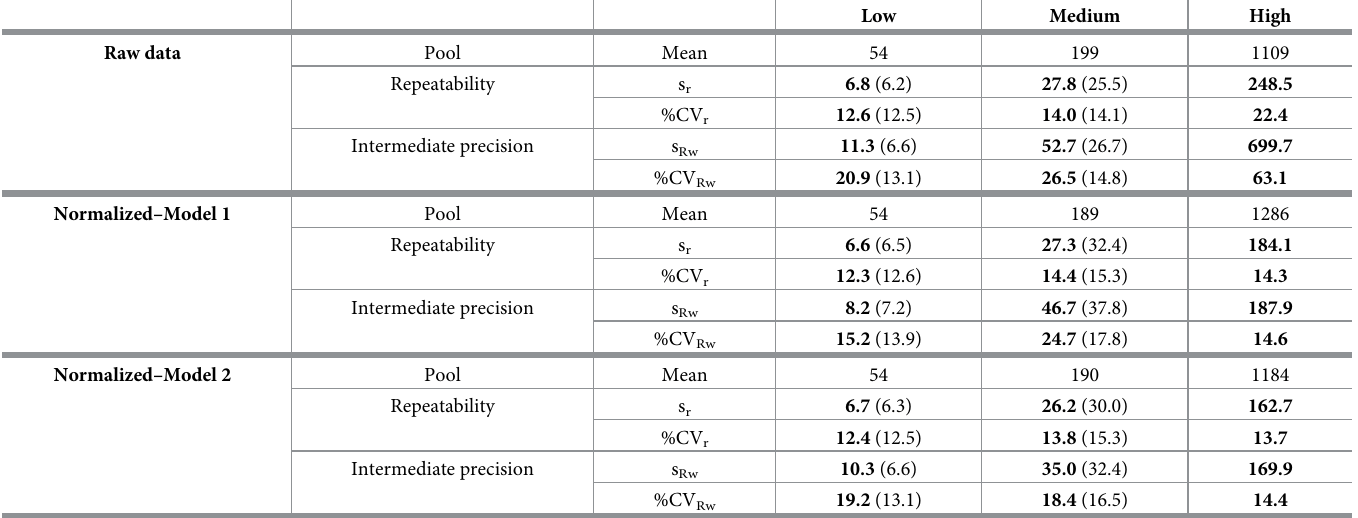
Table 1. Calculations of precision on raw data and on normalized